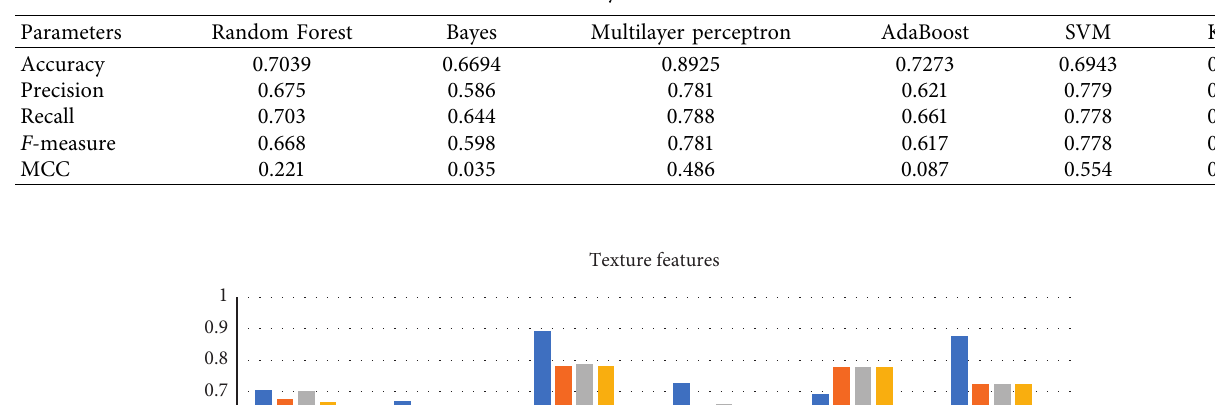
Table 4: Classification accuracy based on texture feature extraction.